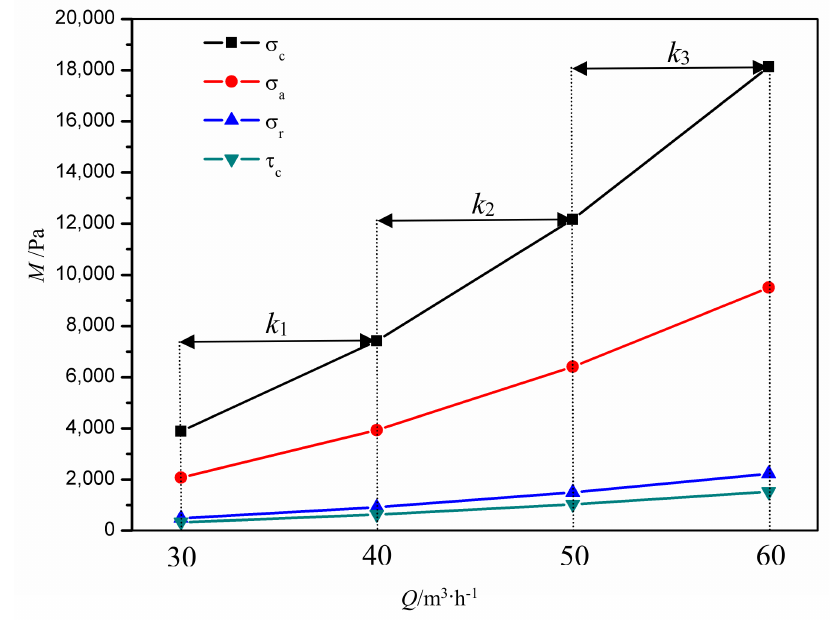
Figure 15. Variation of stress on the cylinder wall of the piped carriage with the flow